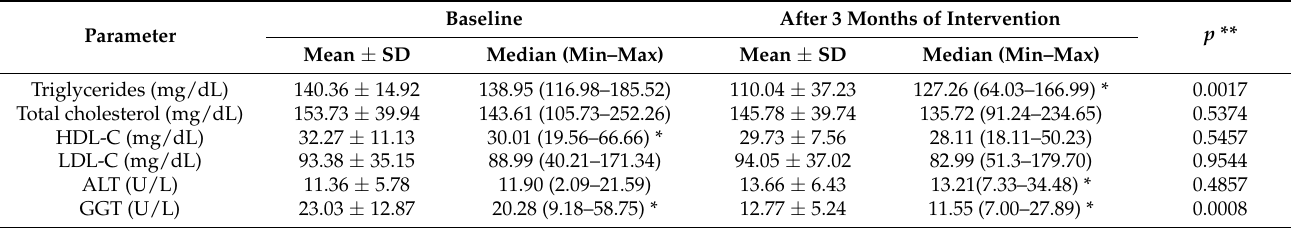
Table 10. The biochemical parameters of the participants at baseline and after 3 months of intervention. Baseline After 3 Months of Intervention Parameter Triglycerides